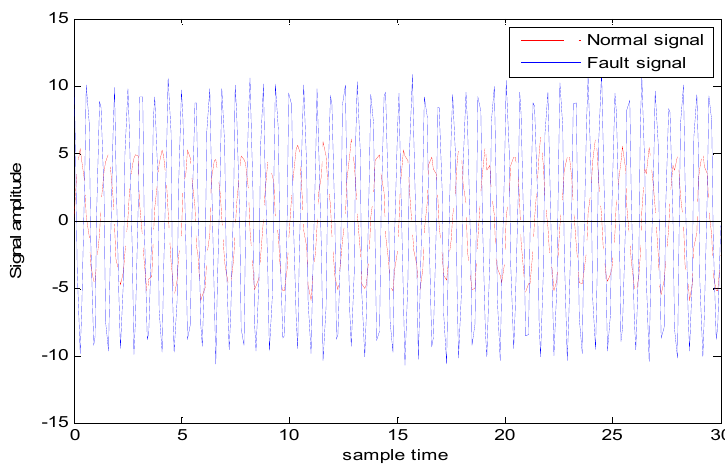
Figure 10. Normal and fault signals with different amplitudes and different frequencies.